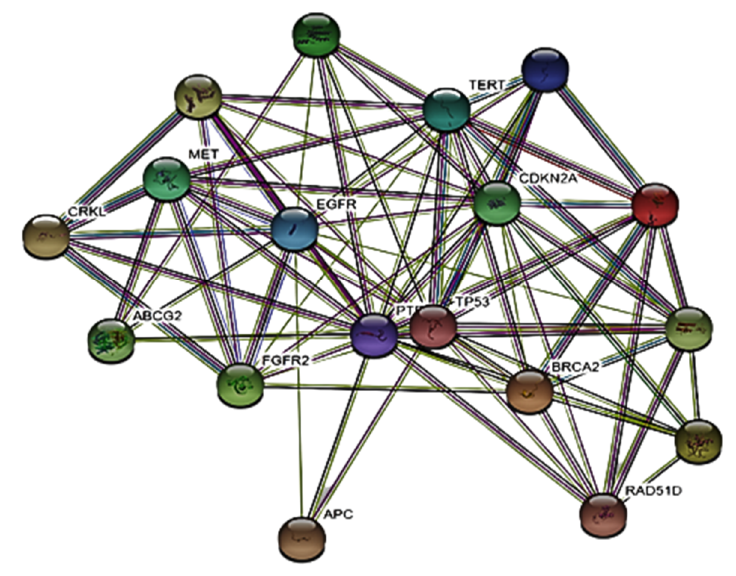
Figure 12. The PPI network of gastric cancer genes. Each node represents the relevant gene, and the edges represent protein–protein associations.